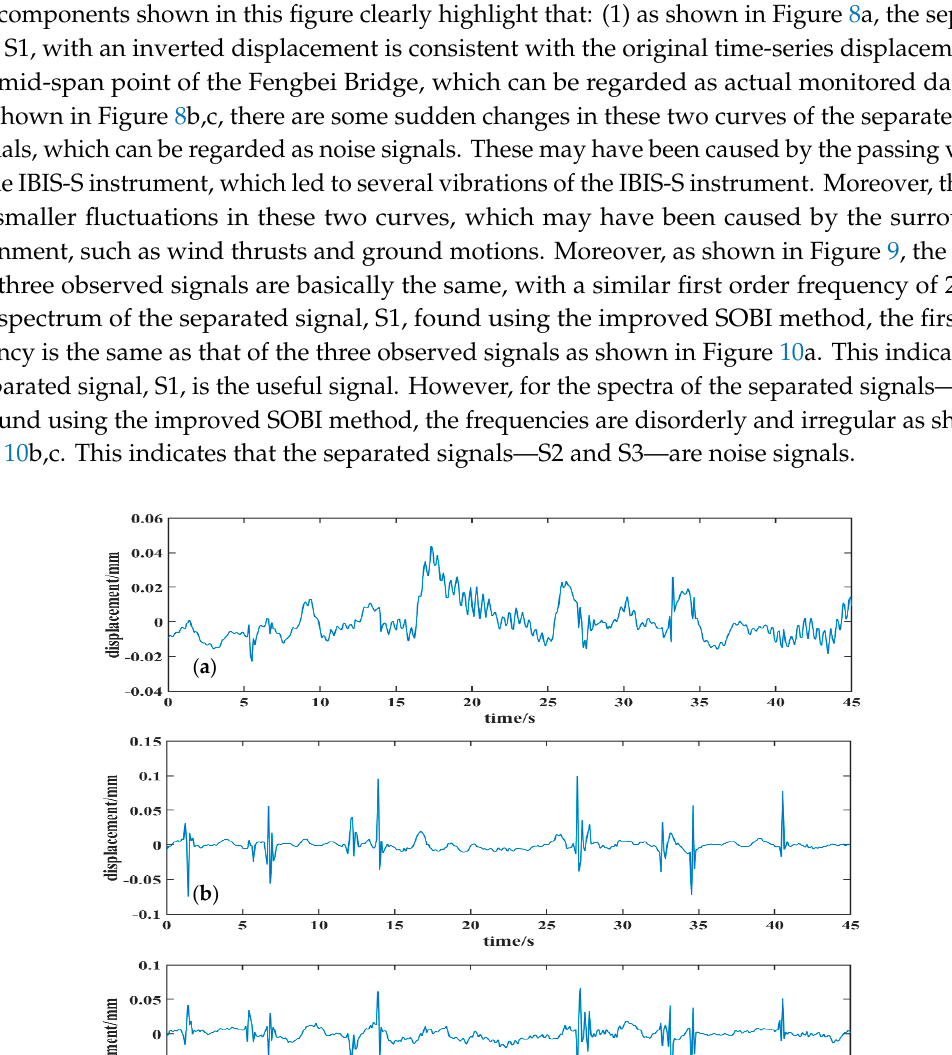
Figure 9. Spectra of the three original observation signals. ( a ) Spectrum of the observed signal X1, ( b ) spectrum of the observed signal X2, and ( c ) spectrum of observed signal X3.